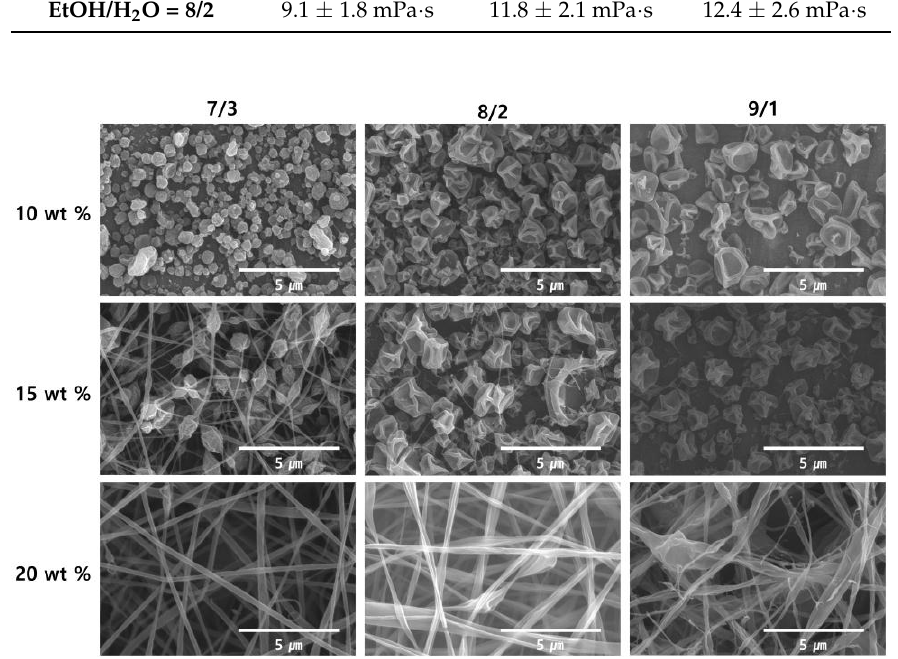
Figure 1. Field emission scanning electron microscopy (FE-SEM) images of zein nanomaterials electrospun from ethanol aqueous solutions with ethanol/water ratios of 7/3, 8/2 and 9/1 ( v/v ) at polymer concentrations of 10, 15 and 20 wt % (Tip-to-collector distance (TCD) = 15 cm and applied voltage = 15 kV).